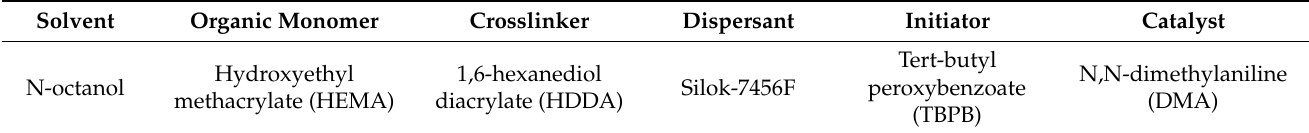
Table 1. The reagents of the gel system used.